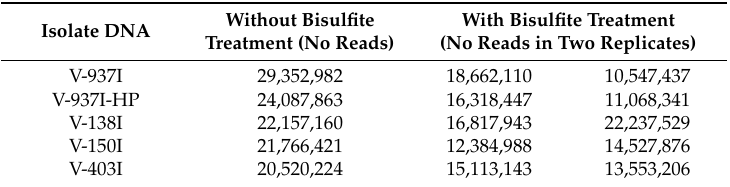
Table 2. Sequencing data of the Verticillium dahliae defoliating isolates.